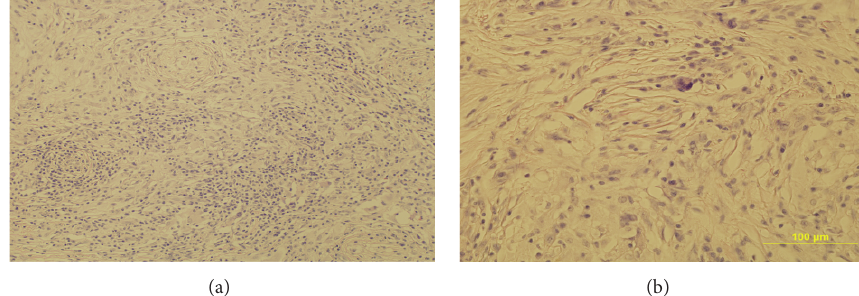
Figure2:(a)Testissectionshowingseverestromalfibrosiswiththepresenceoflargeinfiltratesoflymphocytes,macrophages,andeosinophils. Seminiferous tubules are damaged with extended germinal cell loss. H-E 10x. (b) We observed several giant cell clusters and a severe Leydig cell depletion at the interstitium. H-E 40x.